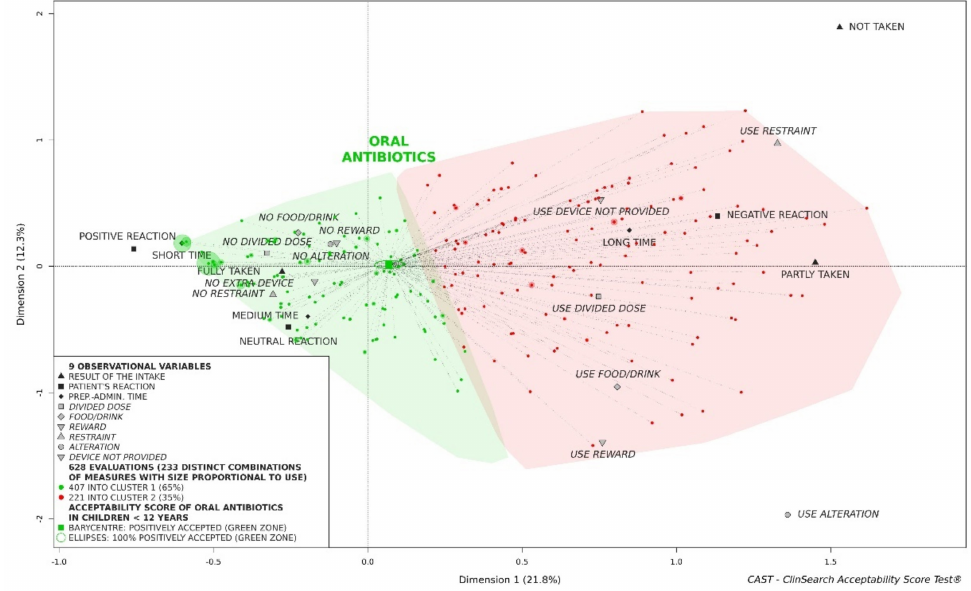
Figure 2. Acceptability scoring of oral antibiotics in children under twelve years of